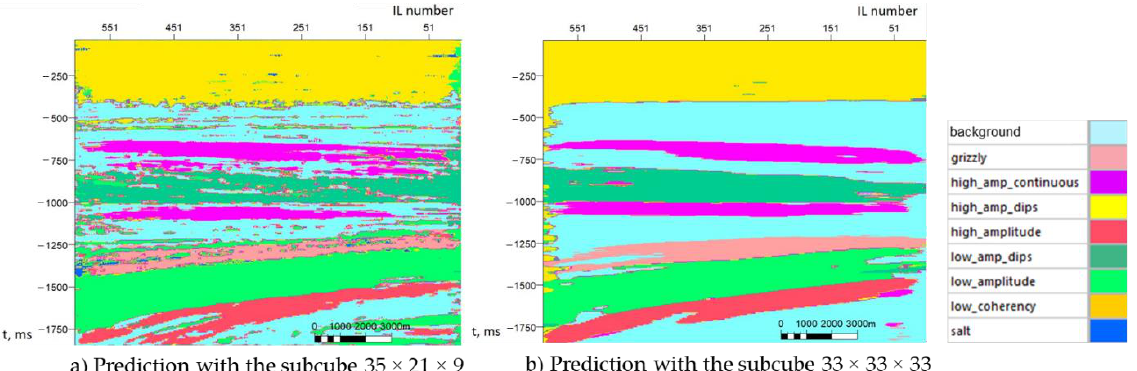
Figure 19. Facies classification for the XL500 with a variogram range sized subcube ( a ) and a 33 × 33 × 33 subcube ( b ). Prediction obtained with a variogram-based subcube has more features and details which could be related to actual geological features.